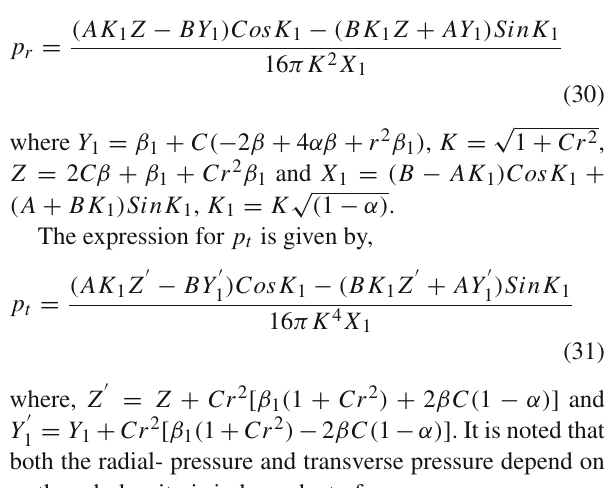
Fig. 1 Radial variation of energy-density of PSR J0348+0432 for β = 1 (red), β = 2 (black) and β = 3 (blue)